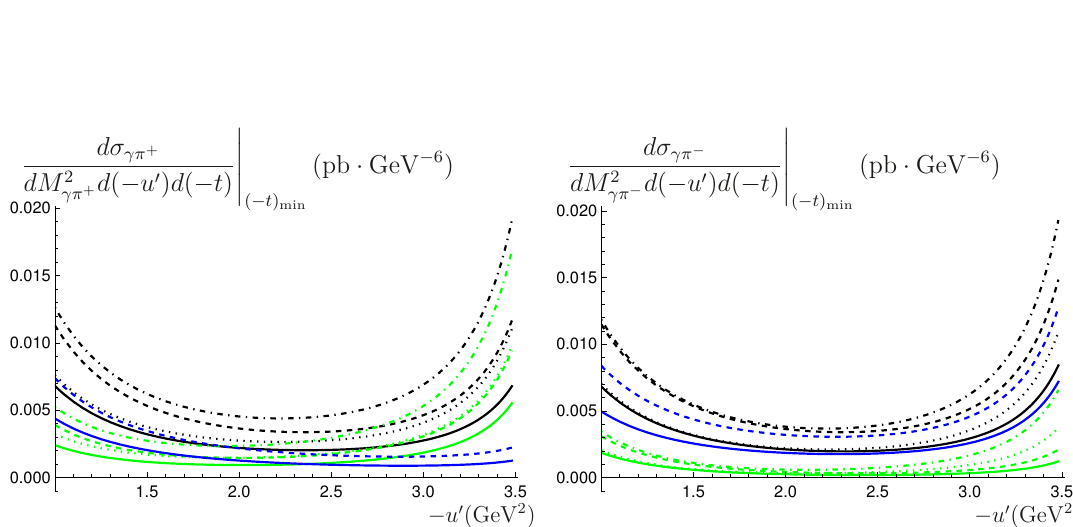
Figure 23 . The fully differential cross-section for π + ( π − ) is shown as a function of ( − u 0 ) on the left (right) for different values of M 2 . The black, red and blue curves correspond to M 2 γπ respectively. The dashed (non-dashed) lines correspond to holographic (asymptotic) DA, while the dotted (non-dotted) lines correspond to the standard (valence) scenario. As mentioned in the text, S γN is fixed at 20000 GeV 2 here.